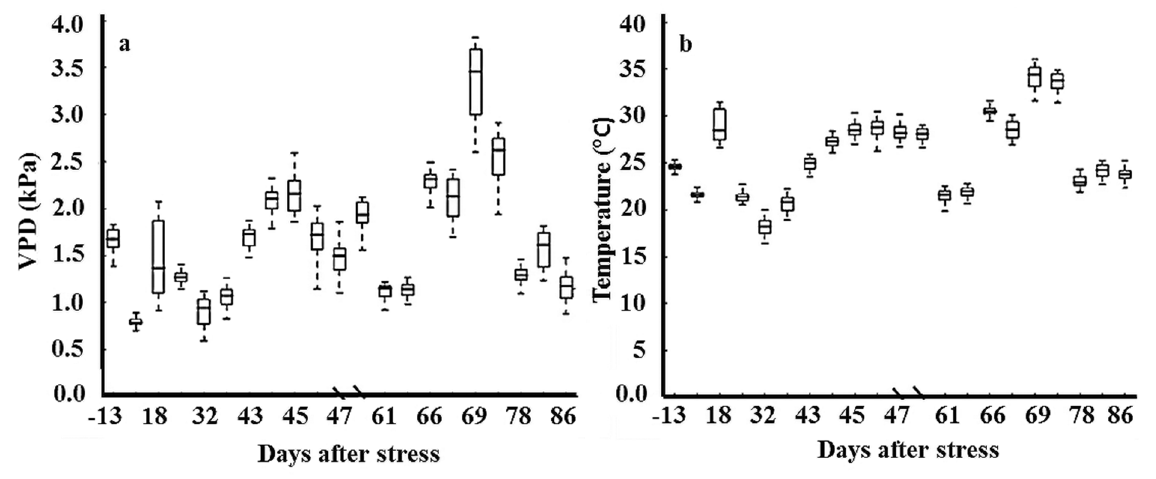
Figure 2. Meteorological data over the length of the experiment, where ( a ) provides the range of the measurements for the vapor pressure deficit (VPD) (kPa) and ( b ) is for the air temperature (°C). The horizontal lines within the box represent the median value, while the top and bottom of the boxes represent the 75th and 25th percentiles. The vertical lines extending beyond the boxes represent the 90th and 10th percentiles. The break in the horizontal axis between 47 and 52 days after stress separates the period of water stress from recovery; n =